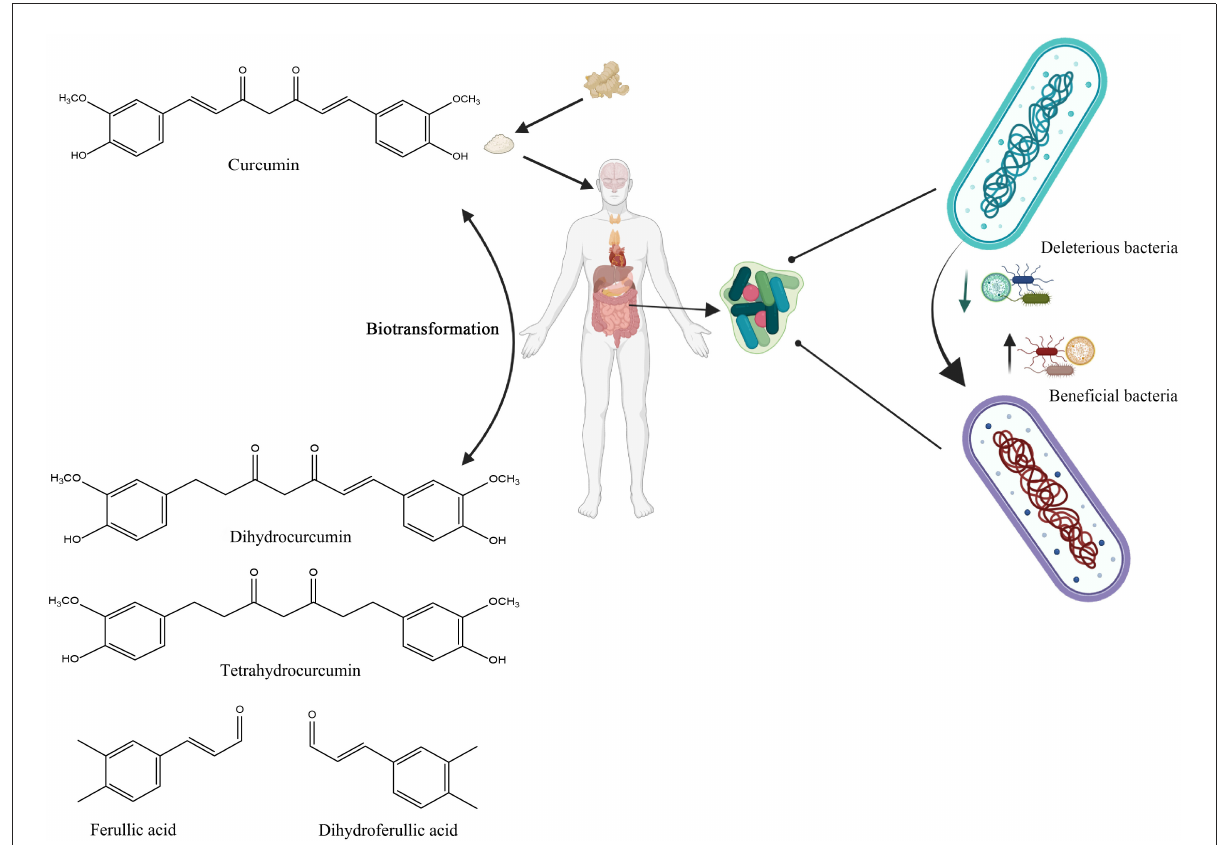
FIGURE4 Schematic illustration of the bidirectional interactions between curcumin and gut microbiota. Created with BioRender.com.